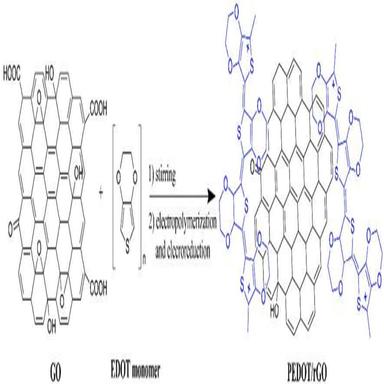
Schematic diagram synthesis of PEDOT/rGO